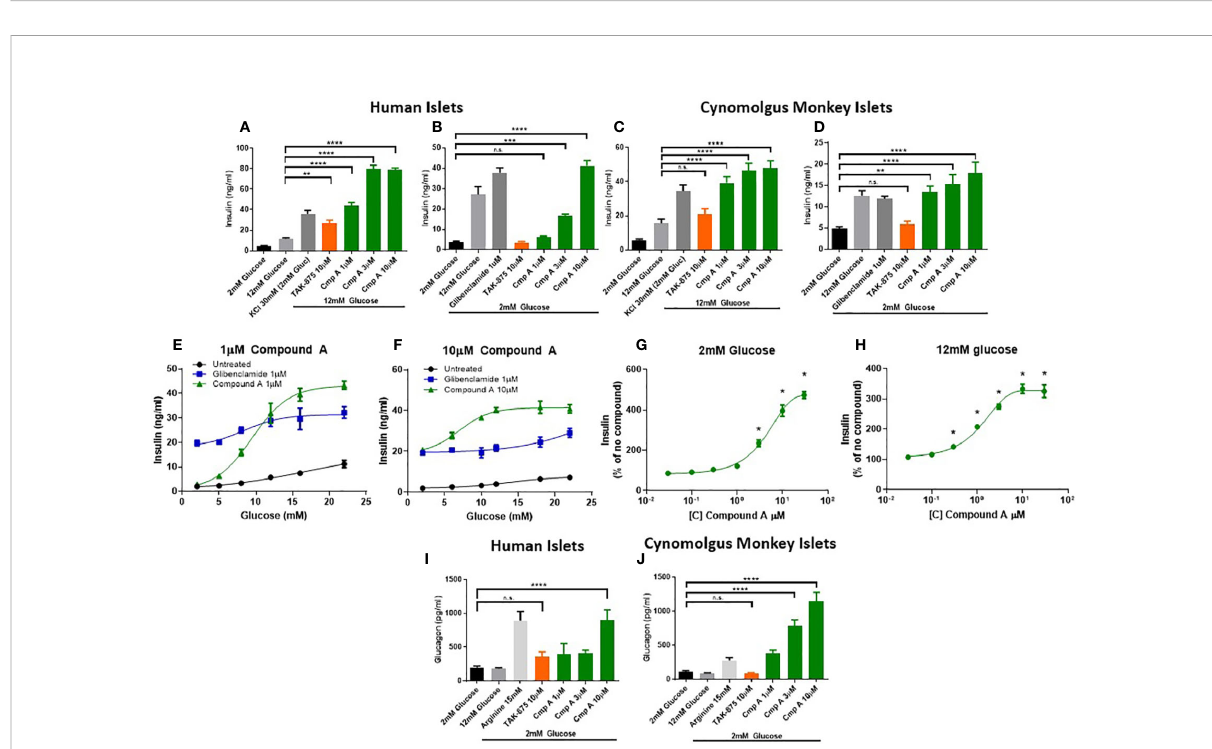
FIGURE 3 Ex vivo islet insulin and glucagon secretion. Insulin secretion from human islets was stimulated with 12mM (A) and 2mM (B) glucose. Cynomolgus monkey islets were also assessed for glucose stimulated insulin secretion in 12mM (C) and 2mM glucose (D) . At low (1 m M) and high (10 m M) concentrations of compound A, glucose dose response curves from a single healthy human islet donor were measured in human islets showing a differential potentiation of insulin secretion at lower glucose levels. Compound dose response curves at 2mM (G) and 12mM (H) glucose expanded on this fi nding to show the effects in low glucose were apparent above 3µM only. Glucagon secretion in 2mM glucose from healthy human (I) and cynomolgus (J) islets. n=3 for all, except (E, F) where n=1. **p<0.01 ***p<.001 ****p<.0001 by 1-way ANOVA vs 2mM or 12mM glucose as indicated in (A – D) & (I, J) . * = p ≤ 0.05 by 2-way ANOVA for (G, H) . n.s.,